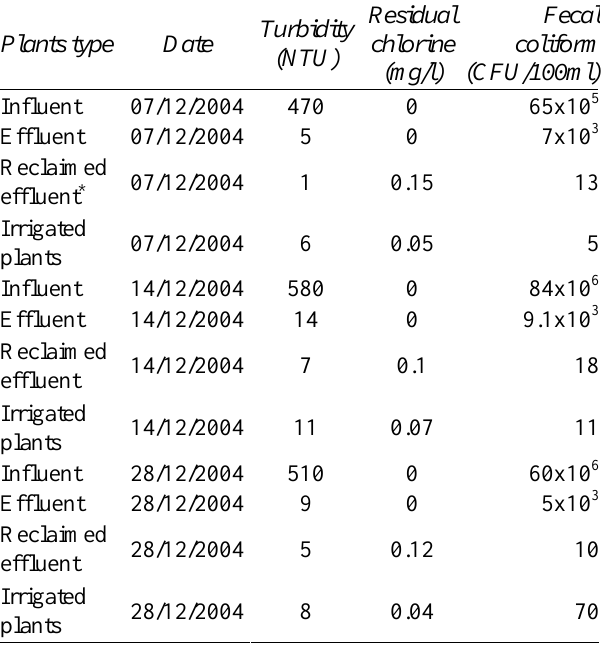
* Effluent reclamation through sand filter and chlorination